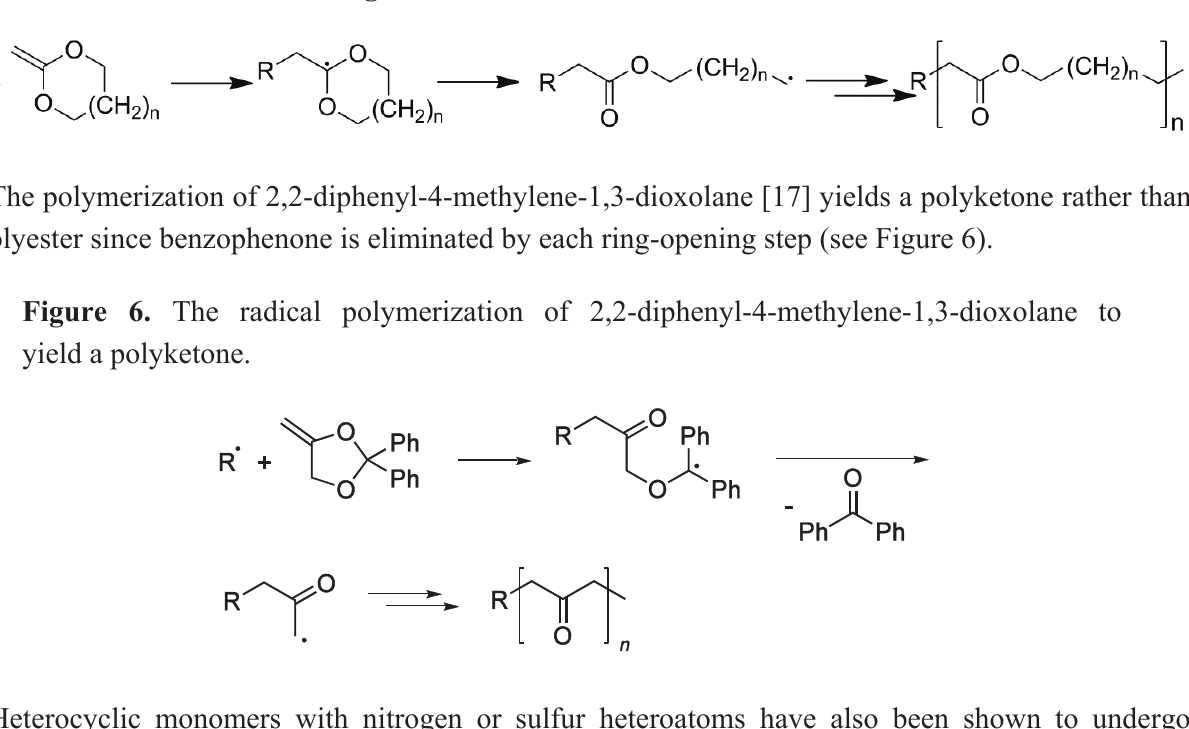
Figure 5. The RROP of ketene